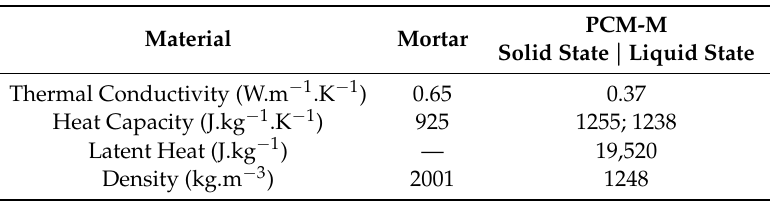
Table 4. Material